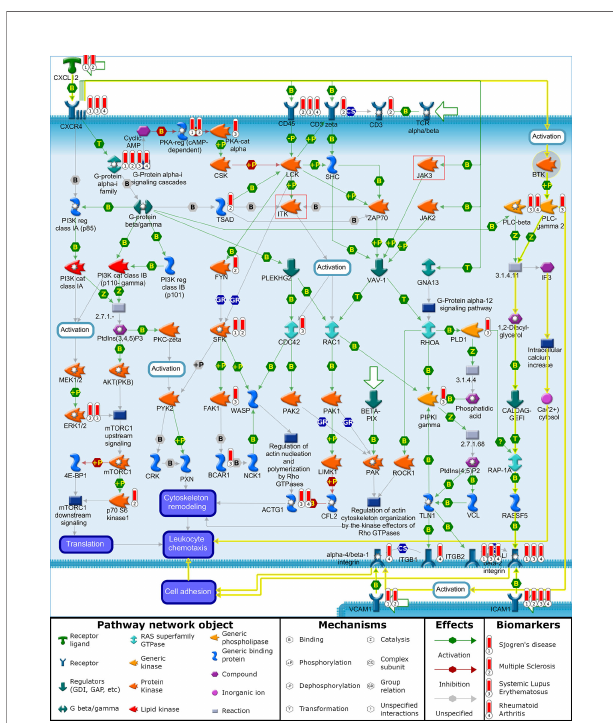
FIGURE 1 | “ Chemotaxis_CXCL12/CXCR4-induced chemotaxis of immune cells ” . Illustration generated with MetaCore pathway analysis tool indicating the involvement of BTK and disease biomarkers to induce chemotactic response in immune cells leading to cell adhesion and cell migration. Data overlaid onto the pathway map are represented as thermometers which typically would indicate the level of over/under expression of a gene. Thermometer 1 represents SJ biomarkers, thermometer 2 represents MS biomarkers, thermometer 3 represents SLE biomarkers, and thermometer 4 represents RA biomarkers. For demonstration purposes, each of these biomarkers was given a value of 1.